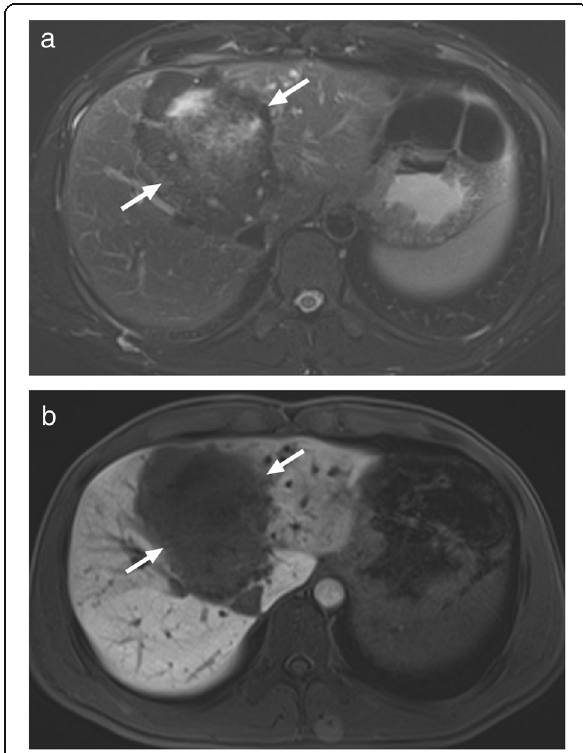
Fig. 4 A 27-year-old male patient with no known past medical history presented with jaundice and right upper quadrant pain. a Axial plane T2W image demonstrates a large, mostly hypointense mass with lobulated borders (arrows). b Axial plane postcontrast hepatobiliary phase T1W fatsat image better demonstrates the borders of this mass (arrows). Percutaneous biopsy revealed alveolar hydatid cyst